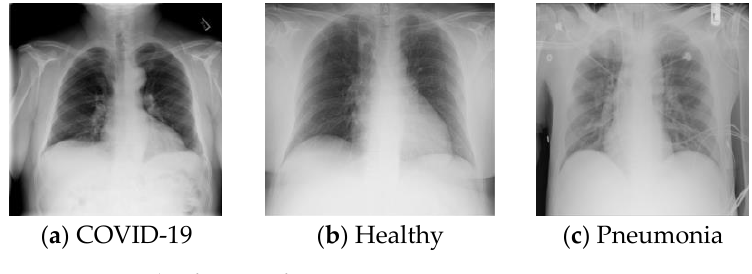
Figure 2. Sample of images from DB2.